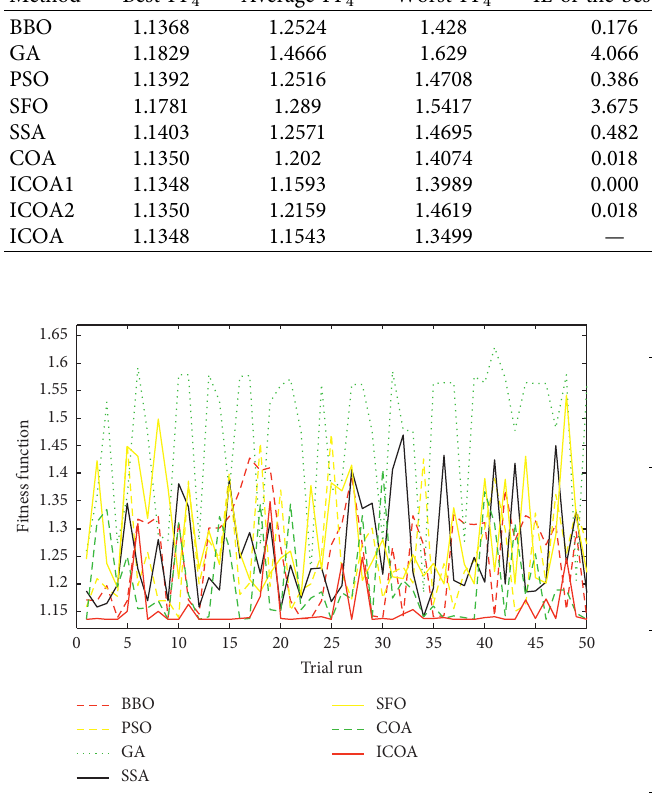
Table 10: The comparison among nine methods of the IEEE 33-bus distribution network for the fourth case. Method